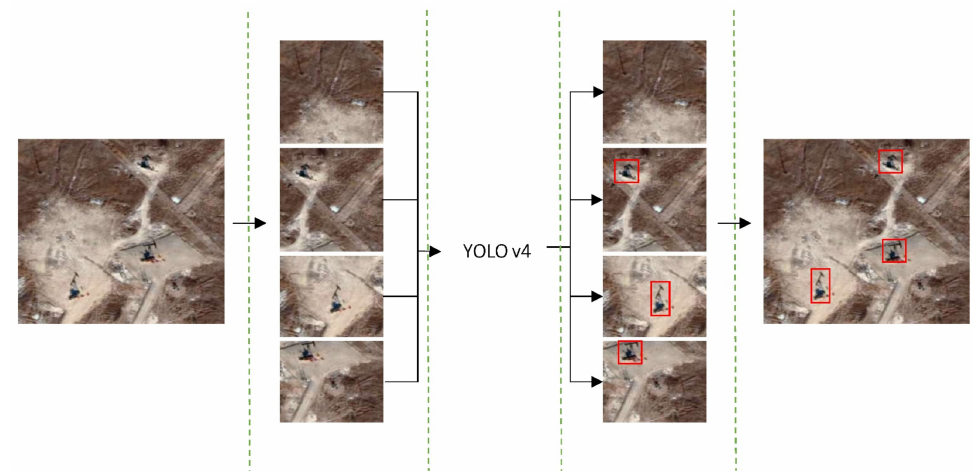
Figure 9. Flowchart of detecting remote sensing images in slices.